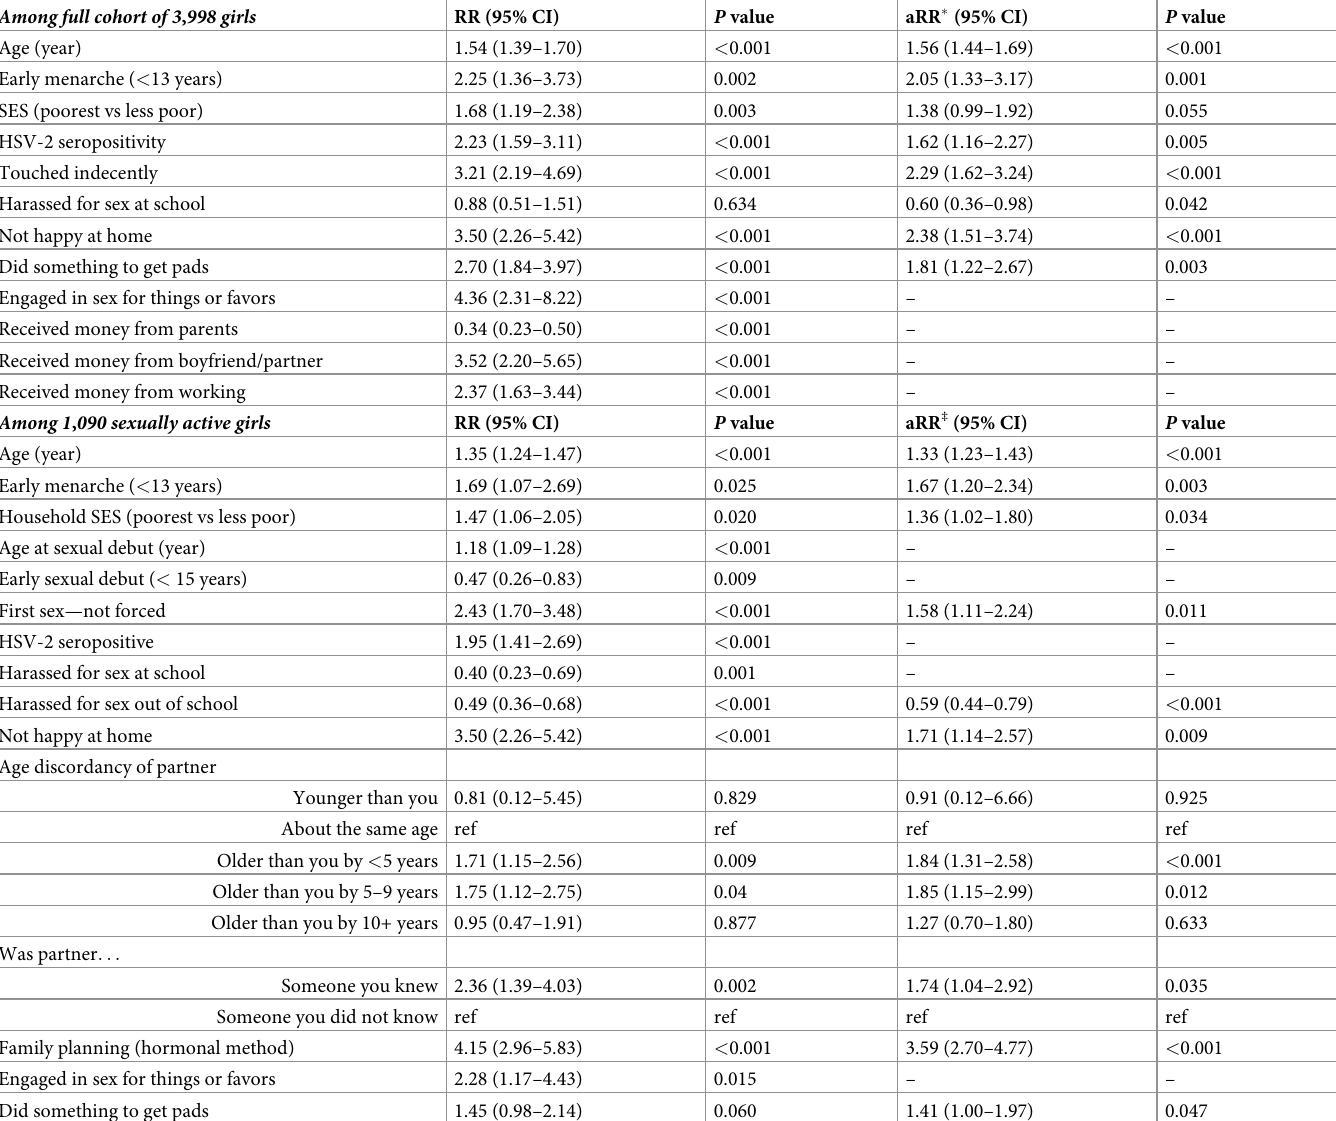
Table 4. Relationship between individual risk factors and adolescent pregnancy among girls attending secondary school, Siaya County, western Kenya, 2017–2018. Among full cohort of 3 , 998